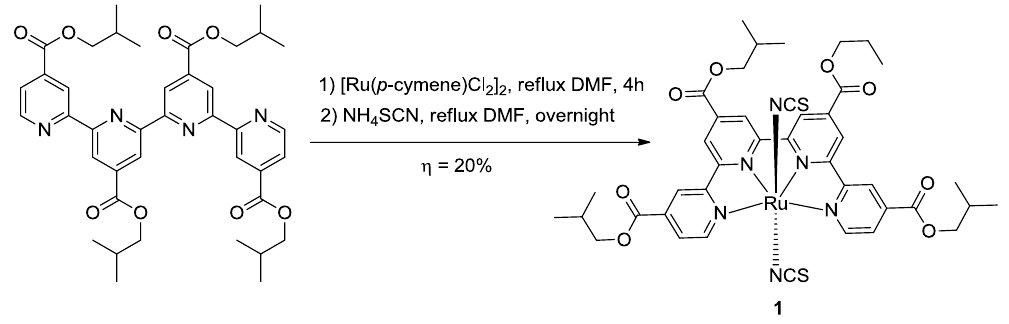
Figure 4. Structure proposed by Wang et al. and N3 dye [71].